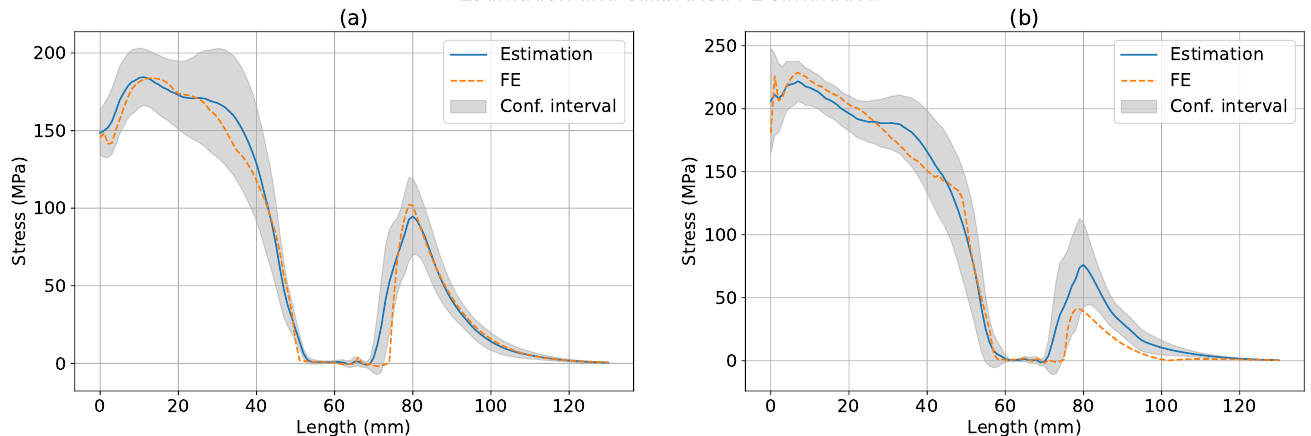
Figure 13. Maximum principal stress estimation obtained from infrared experimental data, FE simulation and confidence interval. ( a ) Camera side. ( b ) Torch